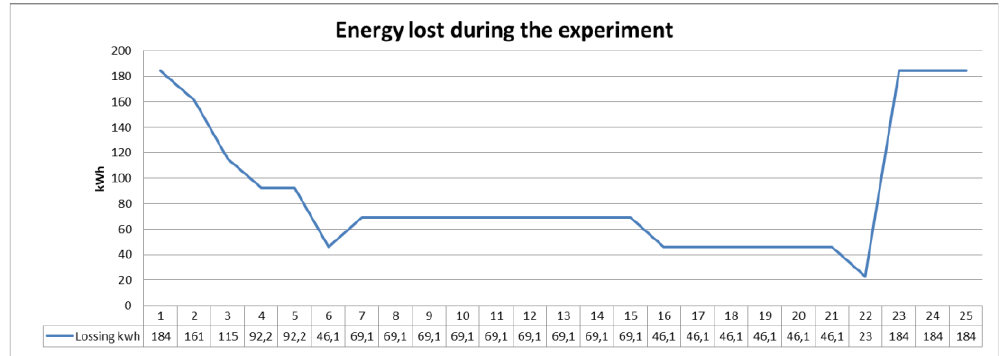
Figure 6. The profile of heat loss for